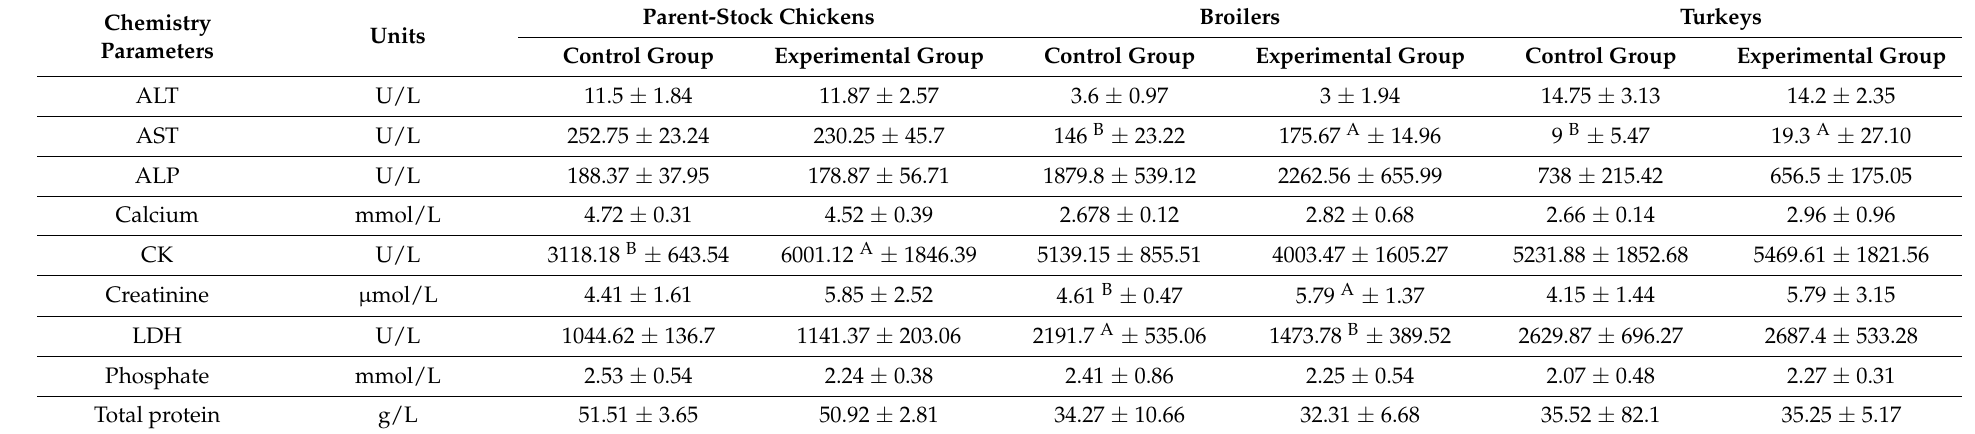
Table 2. Values ( ± SD) for clinical chemistry parameters in serum samples of parent-stock chickens, boilers, and turkeys